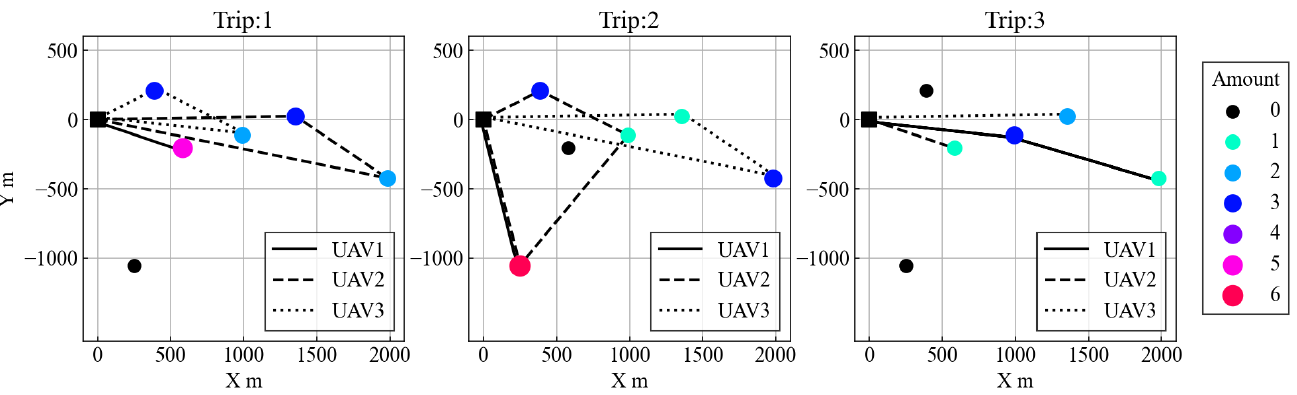
Figure 13. Route and resource allocation to minimize the objective value of Case 1 in Scenario 1. The lines represent the route of each UAV, and the color and size of the dots represent the amount of supplies supplied to each shelter.